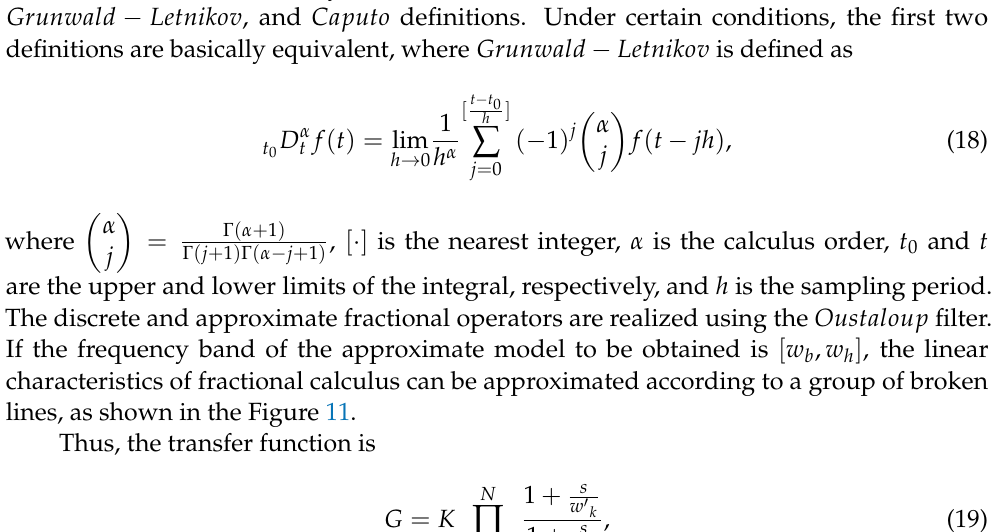
Figure 10. Identify fit plots.